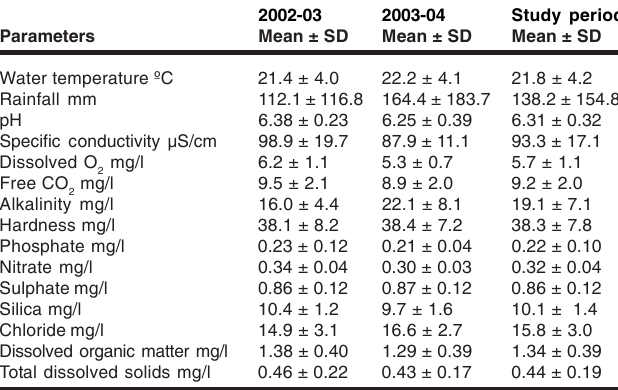
Table 1. Abiotic factors of Loktak